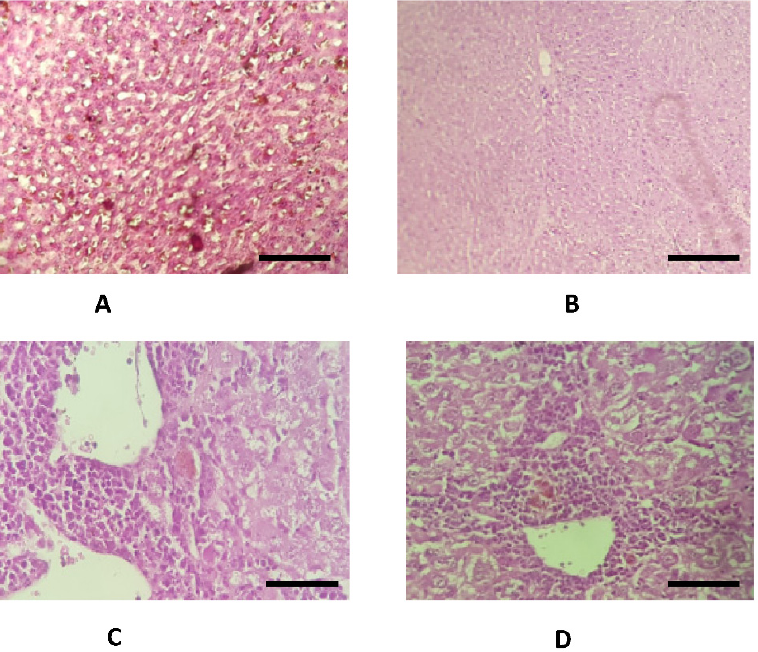
Figure 6. Microscopic photomicrographs of liver slices stained with HES (Hematosin and Eosin) (×40). ( A ) Liver section of untreated mice (group 1) with normal liver parenchyma; ( B ) liver section of group 2 (poly A.E) with parenchyma; ( C ) liver section of group 3 (CCl4) with cavitation, degen- eration, and necrosis; ( D ) liver section of group 4 (poly A.E + CCl4) with insignificant histological modifications. Scale bar: 10 mm (×40).